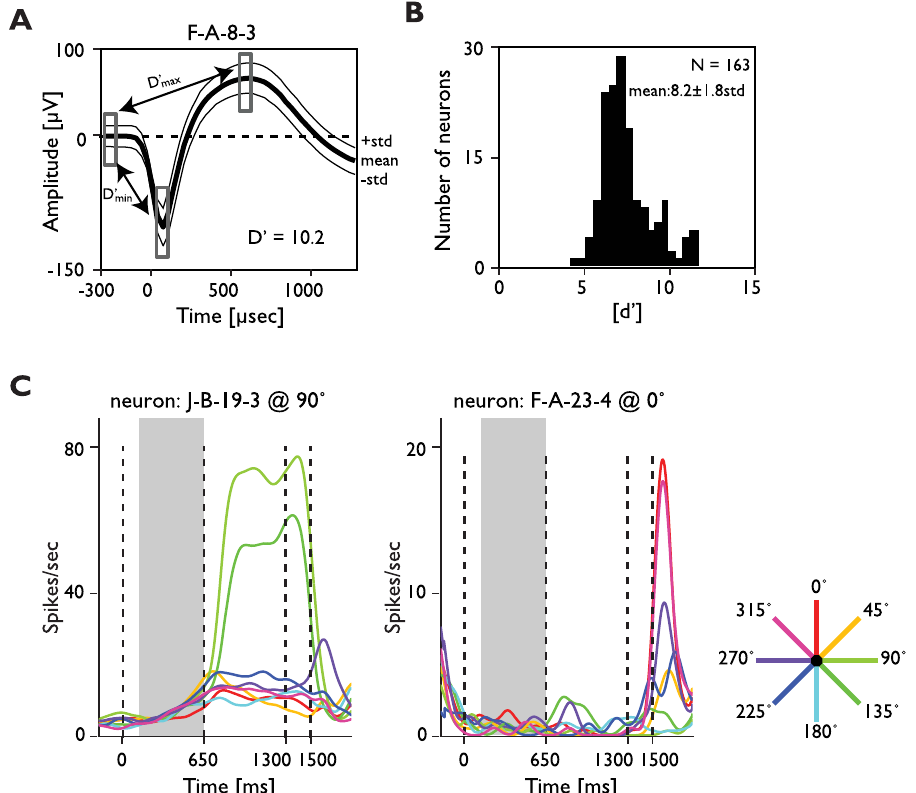
Figure 2. Example neuron, population signal-to-noise and selectivity. A ) Example average waveform from a recorded neuron (solid line). The abscissa represents time from when the threshold was crossed in microseconds ( m s), the ordinate signal amplitude in m V, and the thin lines the standard deviation across waveforms. Rectangles represent the time windows used to measure the standard deviations and to compute d 9 (see Methods). B ) Histogram of d 9 distribution across all single-units. C ) Examples of units’ response (spike density function; s =50 ms) across the different time periods of the task and with different stimulus angular positions (color scale). The gray background indicates the analyzed trial period.